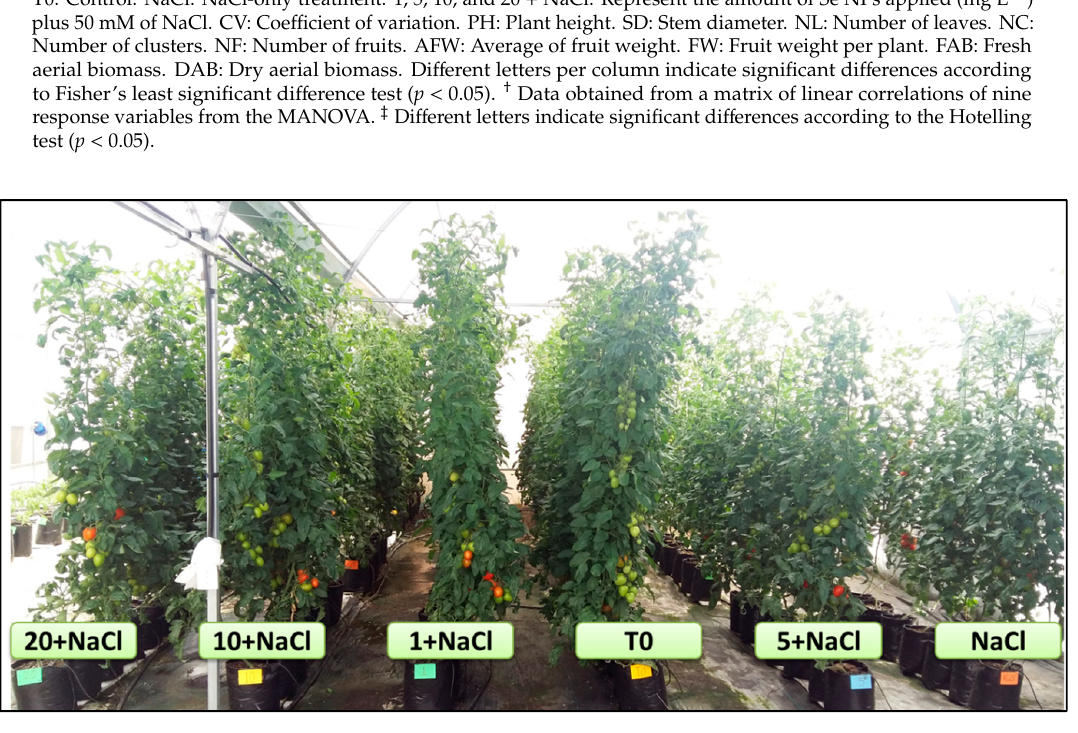
Figure 1. A tomato crop under NaCl stress and an application of Se NPs. T0: Control. NaCl: NaCl-only treatment. 1, 5, 10, and 20 + NaCl: Represent the amount of Se NPs applied (mg L − 1 ) plus 50 mM of NaCl.